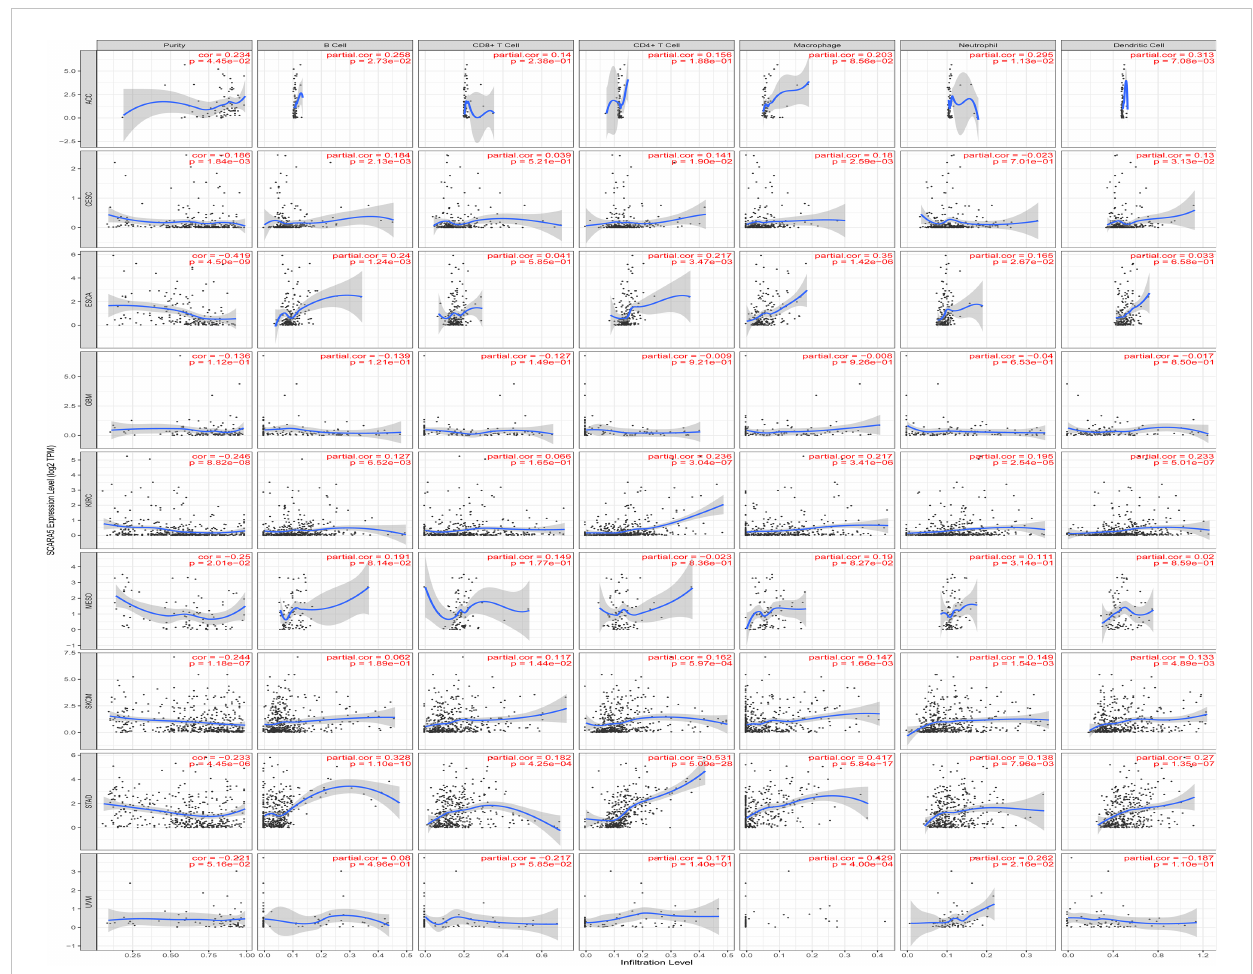
FIGURE 6 The Tumor IMmune Estimation Resource (TIMER) website https://cistrome.shinyapps.io/timer/) is used to view The Cancer Genome Atlas (TCGA) database for ACC, CESC, ESCA, GBM, KIRC, SKCM, MESO, STAD, and UVM in immune cells and the correlation of tumor purity and scavenger receptor class A member 5 ( SCARA5 )